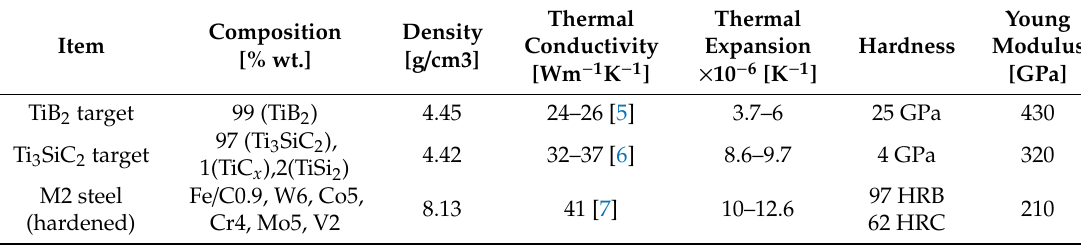
Table 1. Characteristics of targets and substrate